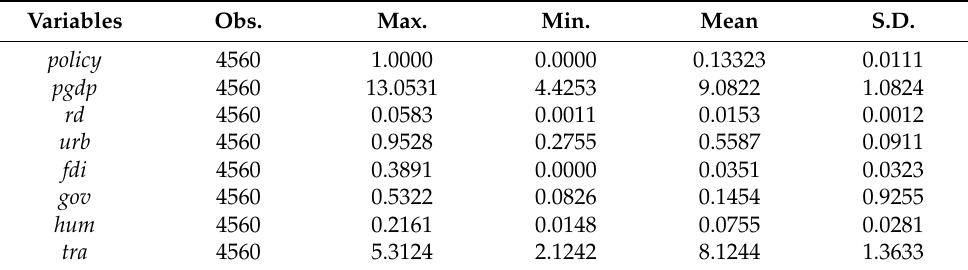
Table 2. Descriptive statistics of the